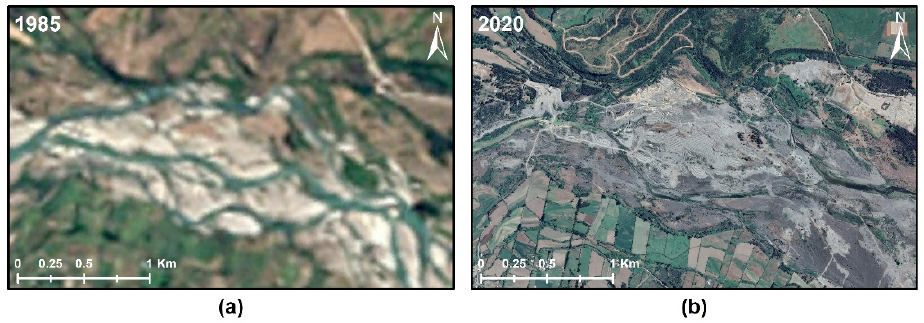
Figure 5. Recorded changes in the channel corresponding in segment 1: ( a ) December 1985, ( b ) October 2020. Source: Modified from Landsat resolution 30 m and Google images. The dynamics of land cover changes between the 1989 and 2018 periods are shown in Figure 6. The bars represent the proportion of hectares that each land cover contributed to the net change of a particular one. It can be observed that more than 55% of the gains in vegetation cover came from active bars, especially in segments 2 and 3, where over 80% of the bar surface area became plant-covered. On the other hand, over 95% of bare soil losses were direct gains for vegetation cover in segments 2 and 3. In segment 1, the dynamic was different; the vegetation cover gains mainly came from bare soils (55%) and water covers (32%), while the active bars accounted for a lower percentage (13%).